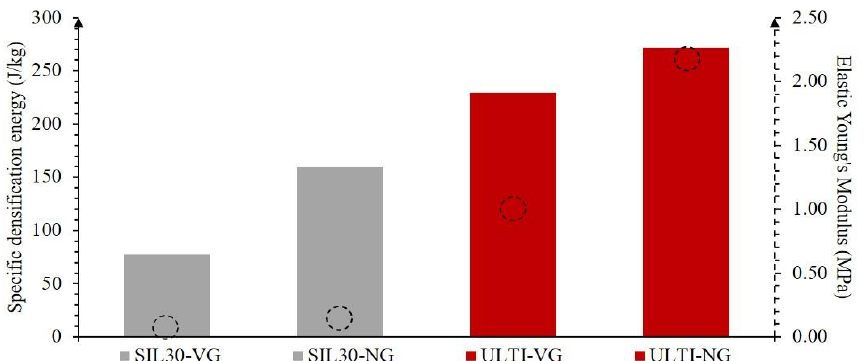
Figure 6. Absorbed energy at the densification point of impact force for the SIL30 and ULTI materials based on the vertically-graded and non-graded configurations, normalized by mass (bars). Elastic Young’s Modulus is shown by the dashed circles and dashed axis on the right side to compare material stiffness as well.